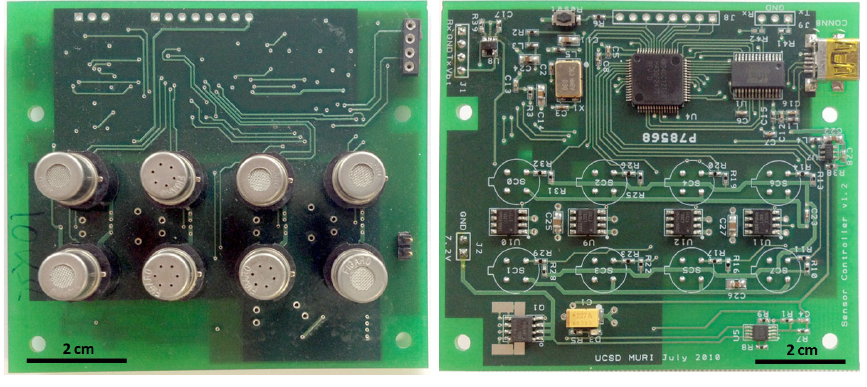
Figure 1. The sensing unit integrates the 8 -sensor array along with the signal processing and signal acquisition